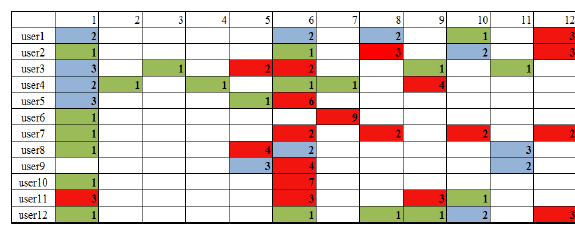
Figure 7: Table showing users frequency based on spatial tasks appearing in clusters. The red colors shows maximum occur- rences while green color shows minimum occurrences